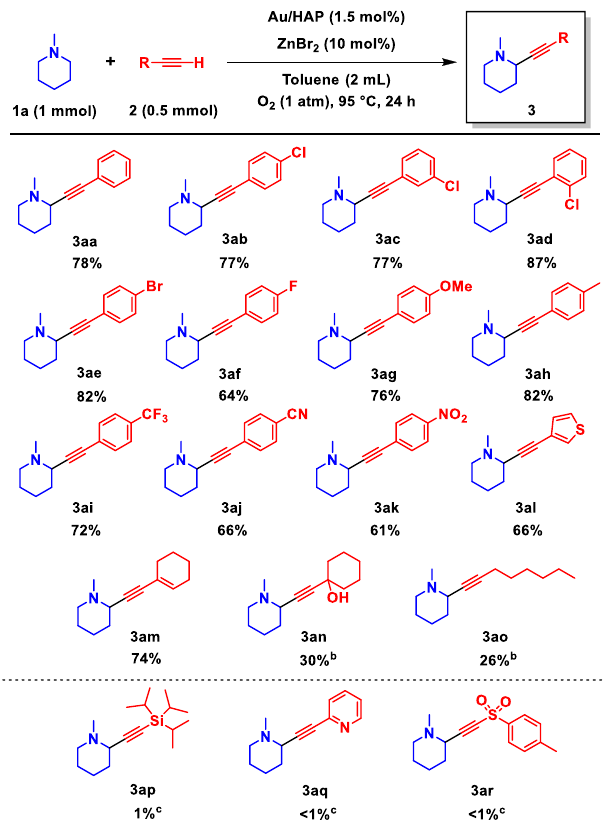
Fig. 2 | Alkyne substrate scope of the combined catalytic system comprising Au/HAPandZnspecies. aa Reactionconditions: 1a (1mmol), 2 (0.5mmol),Au/HAP (100mg, Au: 1.5mol%), ZnBr 2 (10mol%), toluene (2mL), 95°C, O 2 (1atm), 24h. Isolated yields are shown. b ZnCl 2 (50mol%), 36h. c GC yields are shown. HAP